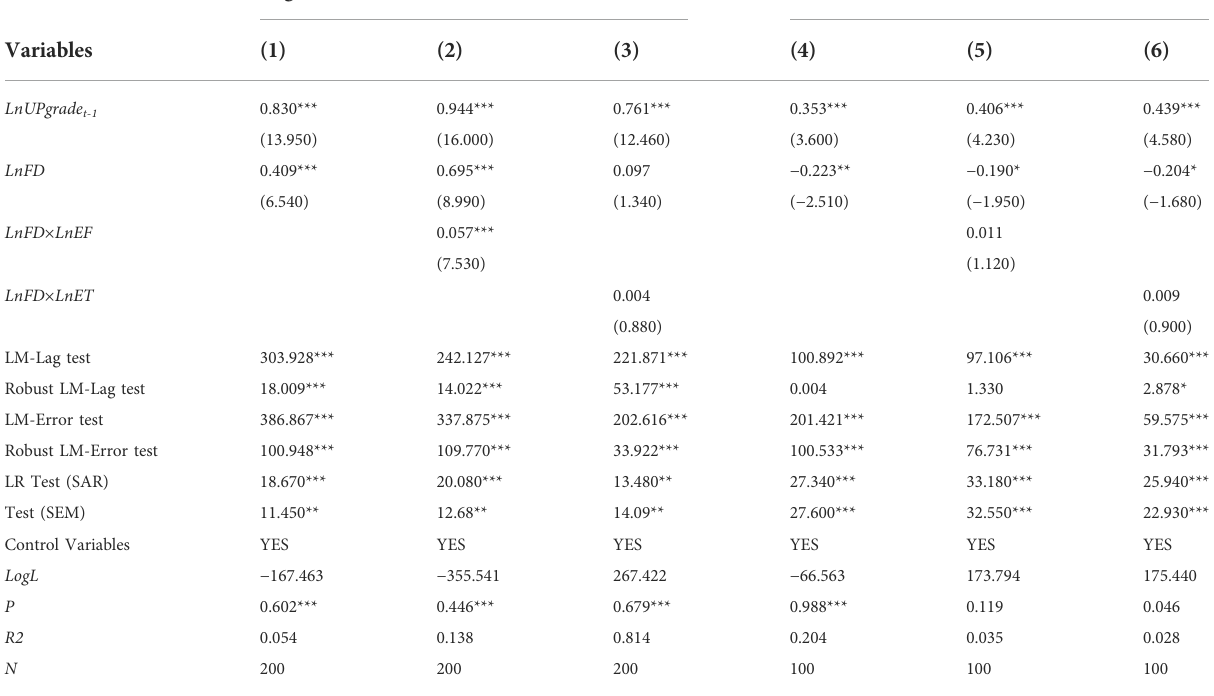
TABLE 12 Estimated results of heterogeneity analysis of